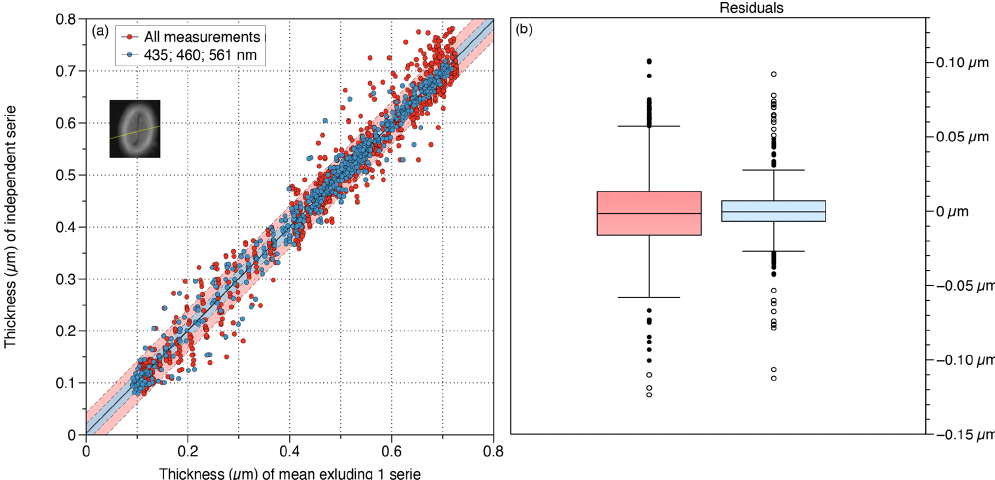
Figure 6. Precision of measurements made on the same 7.74µm transect (yellow line in the inset) across a Pontosphaera japonica (inset) with two cameras and at five or three wavelengths, producing respectively 10 or six series of 129 points. Red: all wavelengths ( r 2 = 0 . 996; RMSE = 0.032µm); blue: 435, 460 and 561nm ( r 2 = 0 . 994; RMSE = 0.012µm). (a) Relation between measure of a thickness series com- pared with the average of all the others. The average thickness of nine (or five) series along a transect and the thickness in the independent (not included in the average) series. The coloured area represents the 80% prediction bounds. (b) Whisker plots of the residual; bars rep- resent the interquartile range, and the box represents the range between the first and third quartiles. Standard deviation = 0.032 (left in red) and = 0.019 (right in